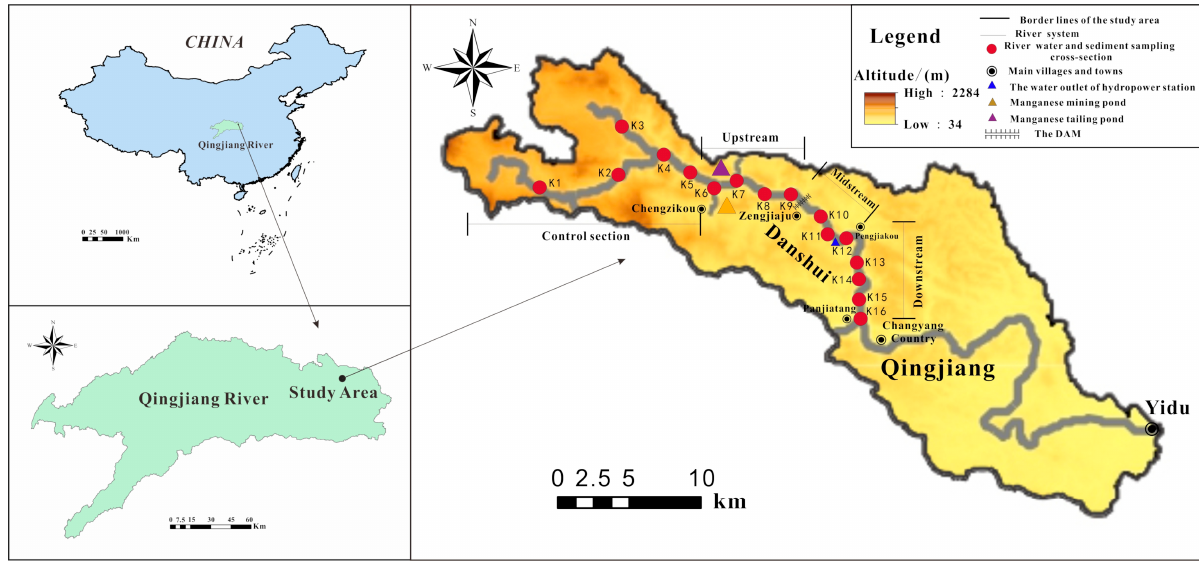
Figure 1. Location of the study area and sampling sites water samples and sediments of Danshui River.